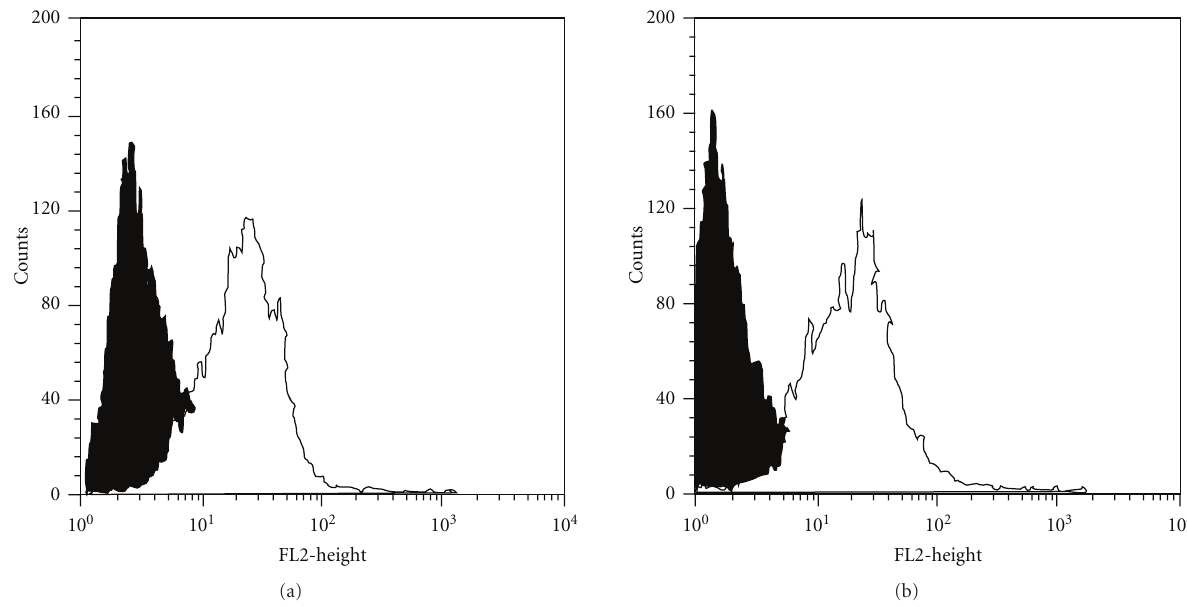
Figure 1: Representative flow cytometry histograms showing (a) TLR2 and (b) TLR4 expression on freshly isolated rat peritoneal mast cells. Filled histograms: isotype controls and open histograms: TLR